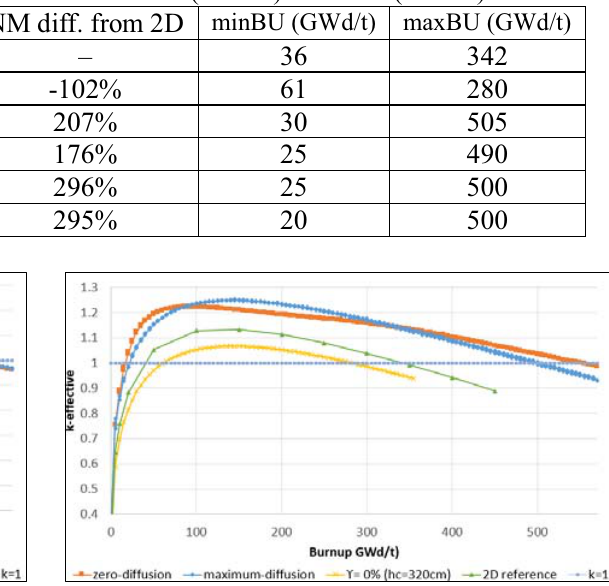
Figure 19. Reactivity-burnup curve for ϒ=22% Figure 20. Reactivity-burnup curve for